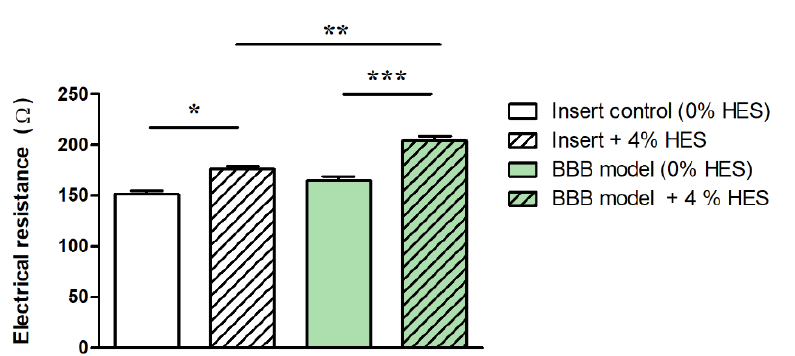
Figure 3. Electrical resistance of immortalized mouse cerebellar capillary endothelial cells (cerebEND) after hydroxyethylstarch (HES) treatment. Transparent columns: cell culture inserts without cells. Green columns: cell culture inserts with the cerebEND cell line modeling the blood–brain barrier (BBB) in vitro. The control groups contained 0% HES. Data are means ± SEM, n = 6–13, two-way ANOVA with Bonferroni post-test; * p < 0.05, *** p < 0.01, *** p < 0.001. Modified from [34].